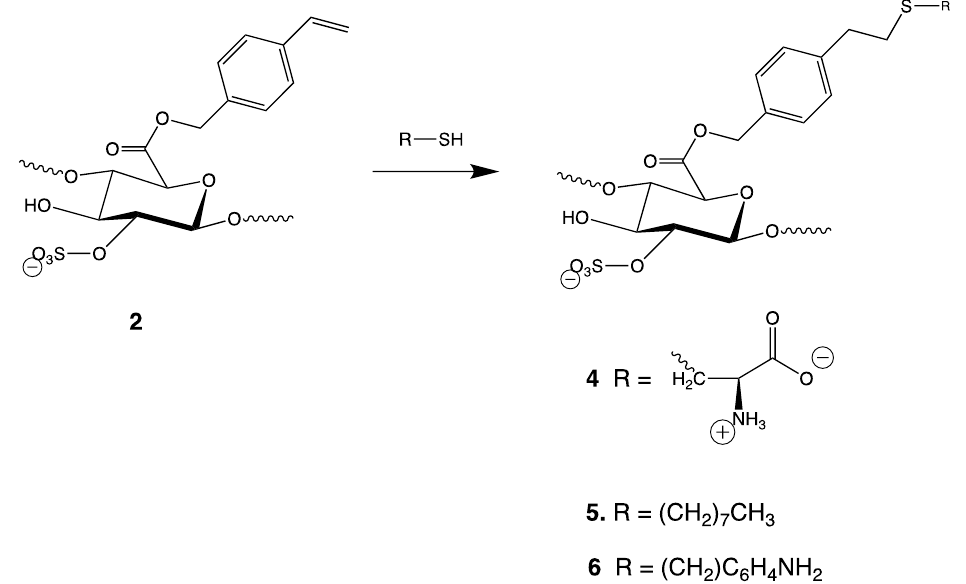
Figure 6. Thiol-ene reactions of heparin 4-vinylbenzyl ester ( 2 ).